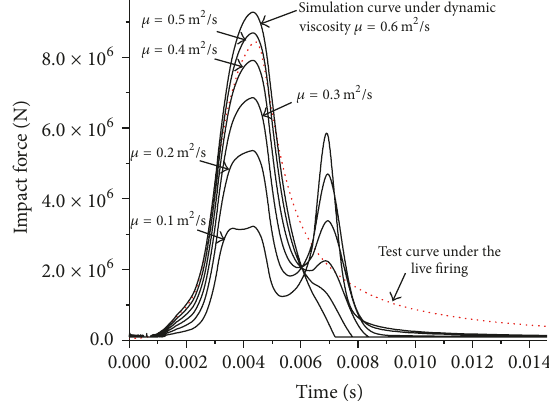
Figure7:Shockforcecurveofthehigh-powerhydraulicshockwave simulator under various dynamic viscosity 𝜇